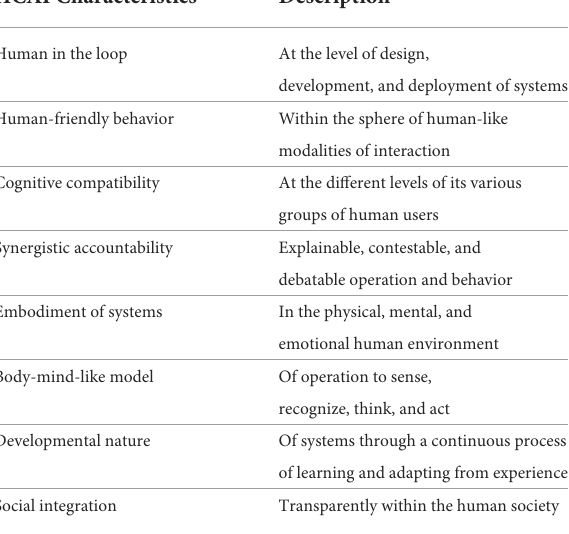
TABLE 1 Major characteristics of HCAI